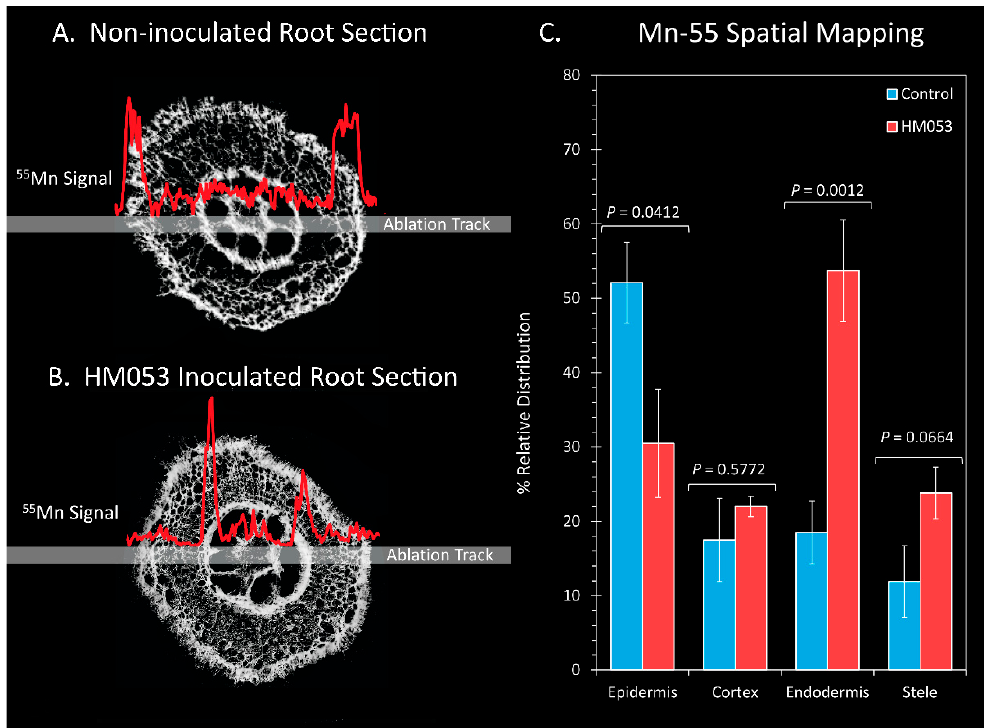
Figure 5. Laser ablation ICP-MS analysis reveals effect of HM053 inoculation on the spatial distribution of Mn-55 across root cells. Panel ( A ): The Mn-55 ion signal across a root section of a non-inoculated control plant. Panel ( B ): The Mn-55 ion signal across a root section of an HM053- inoculated plant. Panel ( C ): Average values ± SE on N = 6 replicates where each replicate was a root section taken from different plants. p values < 0.05 were considered statistically significant.